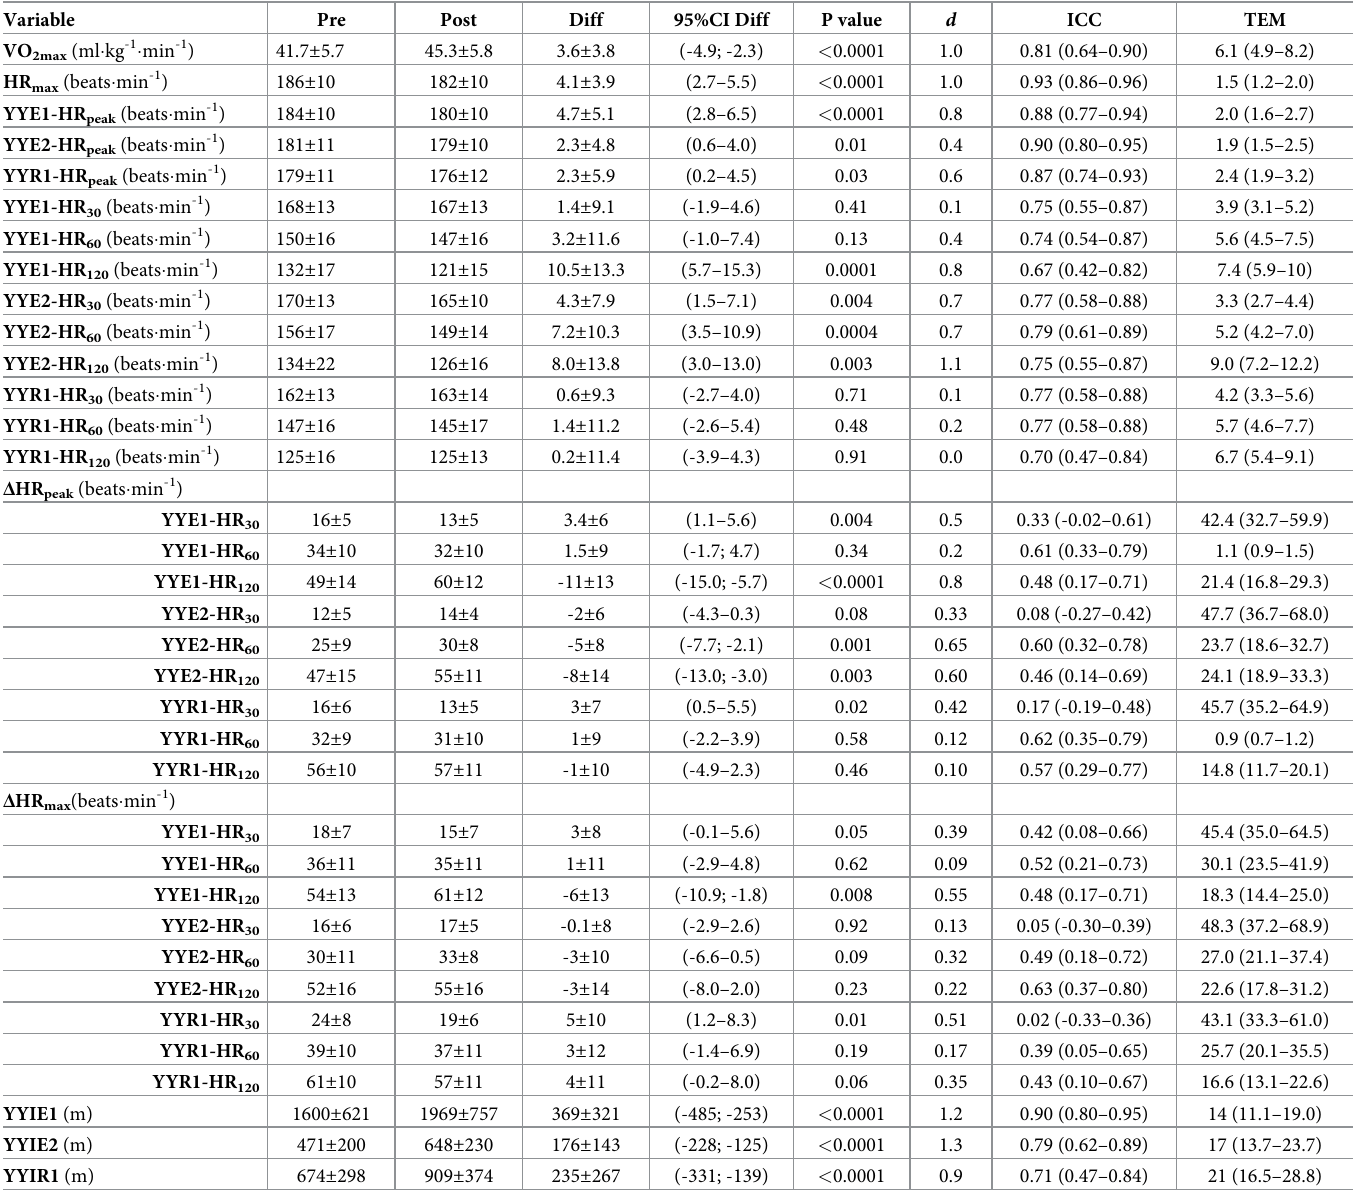
Table 1. Pre- to post-training intervention changes in the considered